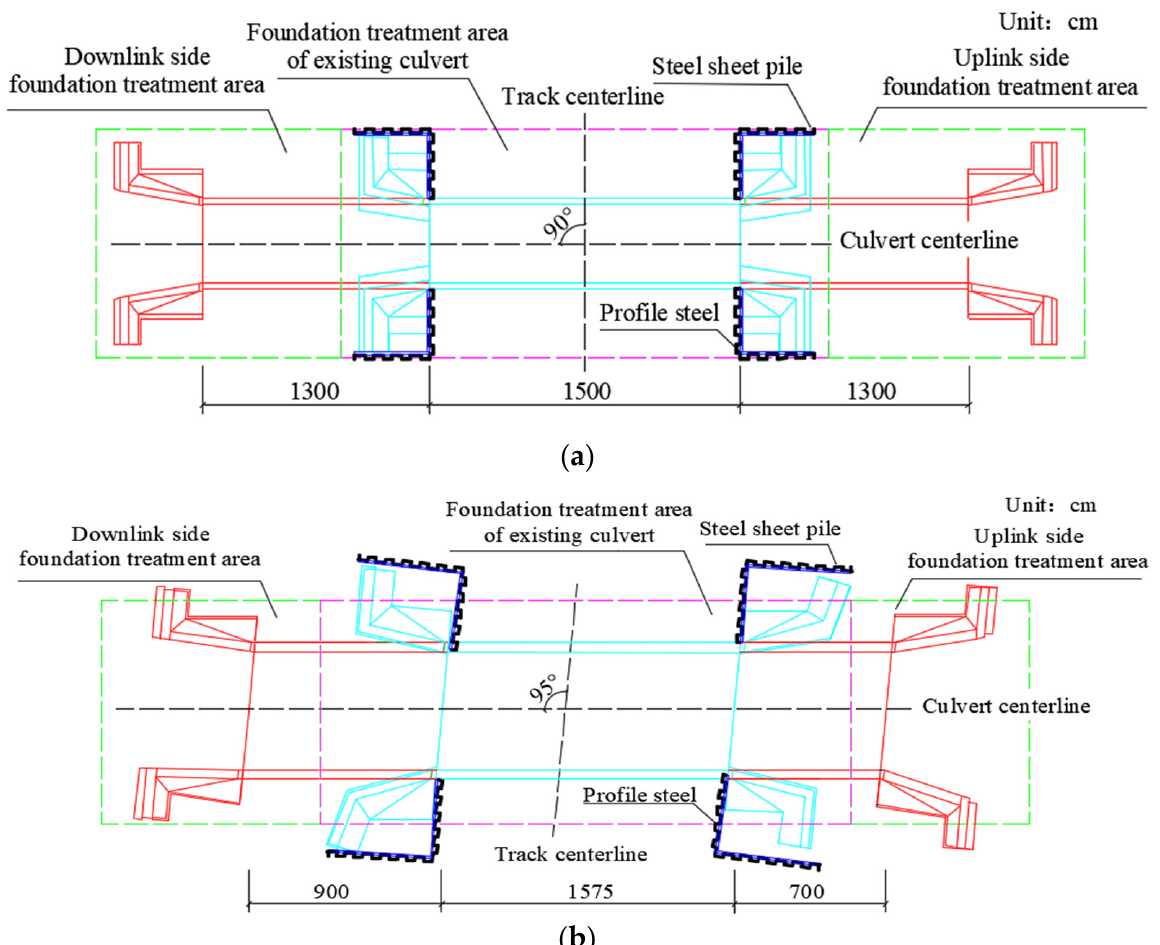
Figure 1. Schematic diagram of the culvert extension project: ( a ) Site 1; ( b ) Site 2.